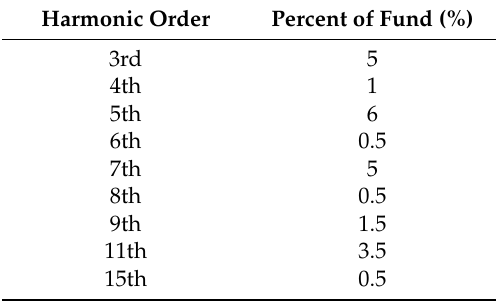
Table 9. EN 50160 limits for individual harmonics at the low voltage Point of Common Coupling (PCC). Harmonic Order Percent of Fund (%) Harmonic